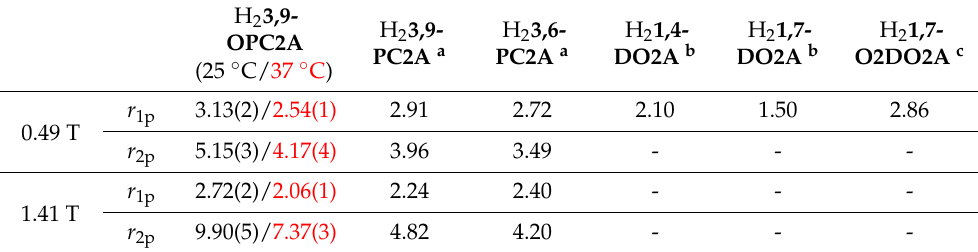
Table 4. The relaxivities (mM − 1 s − 1 ) of the Mn(II) complexes formed with H 2 3,9-OPC2A , H 2 3,9- PC2A , H 2 3,6-PC2A , H 2 1,4-DO2A , H 2 1,7-DO2A , and H 2 1,7-O2DO2A ligands at 25 ◦ C and pH = 7.4 (the values shown in parenthesis are the standard